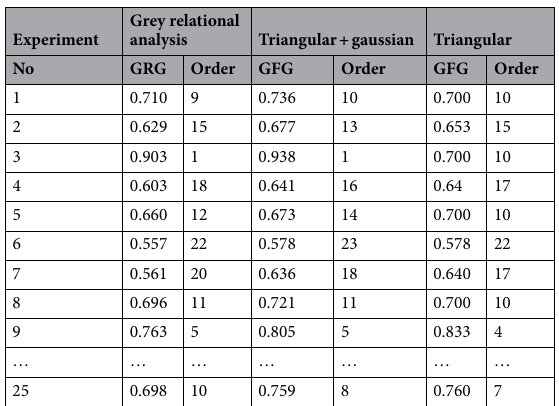
Table 16. The grades and rank by adopting different approaches.